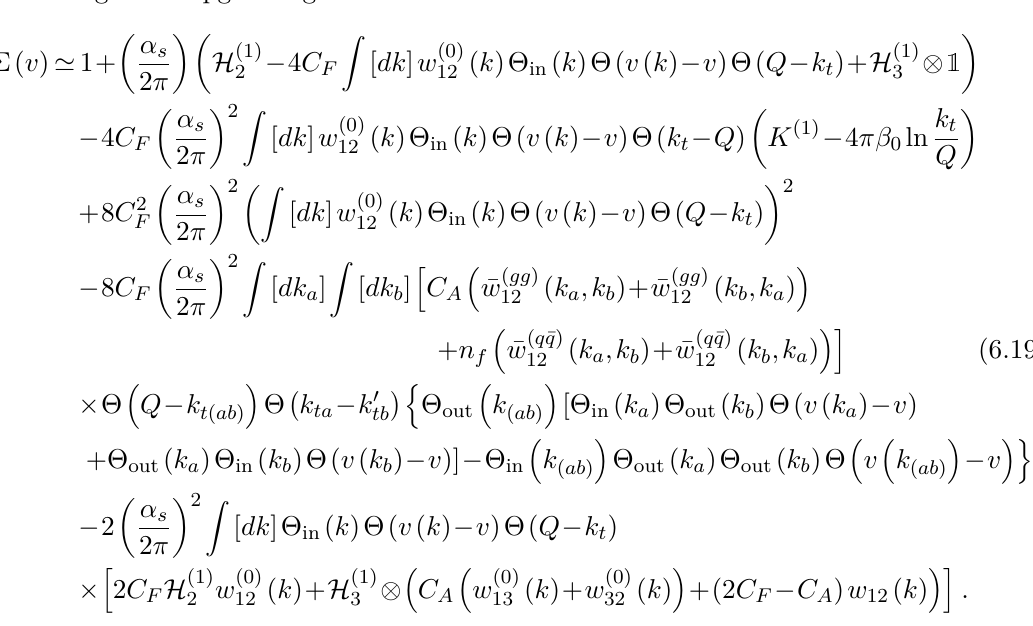
Performing these upgrades